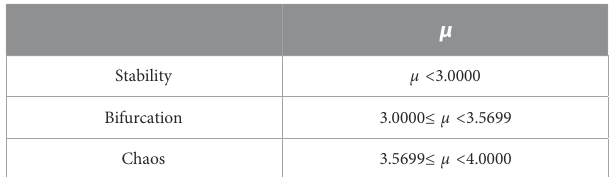
TABLE 1 Critical value of each